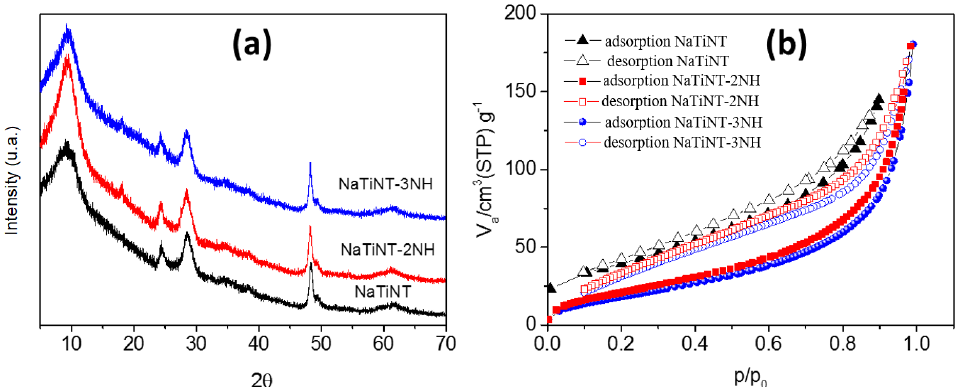
Figure 1. ( a ) X-ray diffraction patterns of sodium titanate nanotubes as synthesized (NaTiNT) and